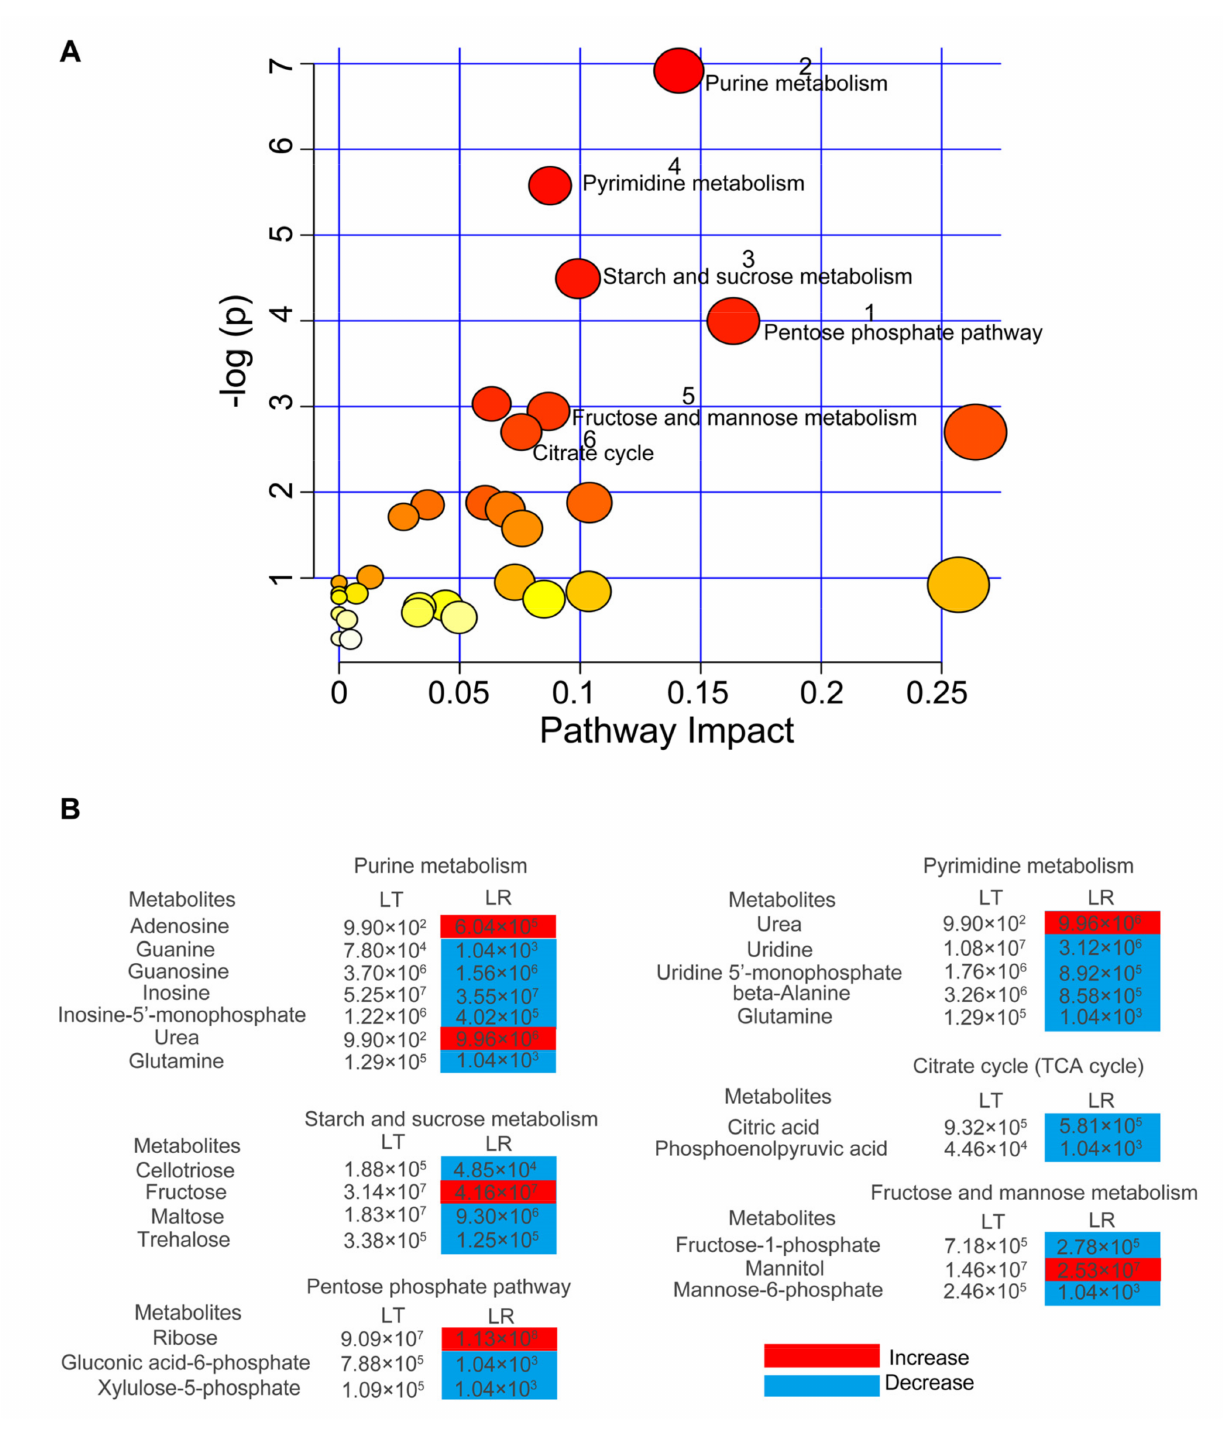
Figure 3. Pathway enrichment and analysis. ( A ) Pathway enrichment of various metabolites. A hypergeometric test was used to calculate the − log( p ) value for reflecting the impact of each metabolic pathway, and pathways with p < 0.05 were retained. Significantly enriched pathways were selected for plotting. According to the impact value, 1 to 6 are, respectively, the pathways of pentose phosphate, purine metabolism, starch and sucrose metabolism, pyrimidine metabolism, fructose and mannose metabolism, and the citrate cycle (TCA cycle). ( B ) Integrative analysis of metabolites in significantly enriched pathways. Compared with LT, red and blue indicate an increase or decrease of metabolites in LR, respectively. Number shows the relative area of varied